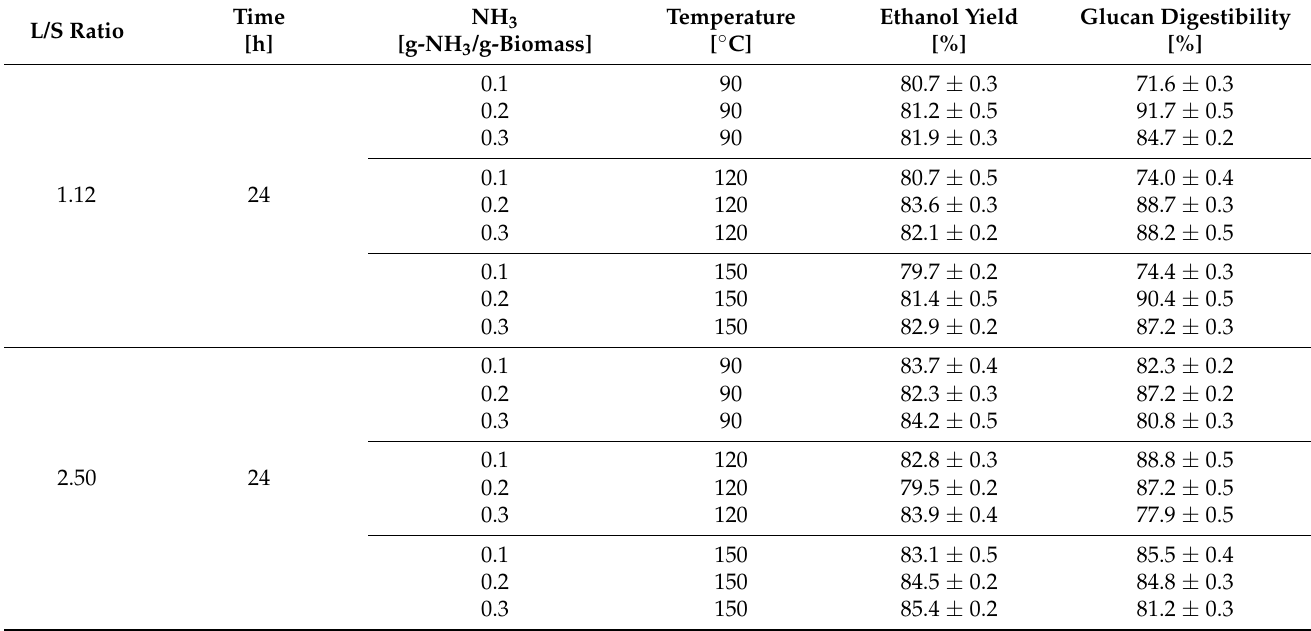
Table 6. Effects of ELLA treatment conditions on ethanol